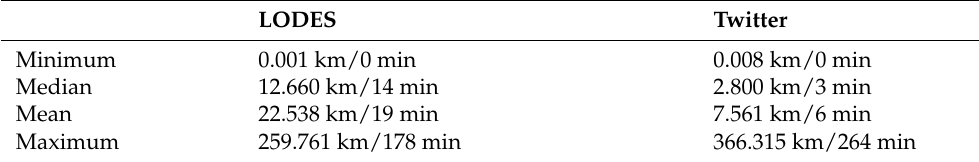
Table 6. Trip lengths on the OSM network.